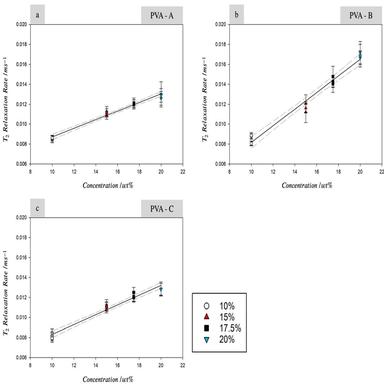
MR T2 Relaxation Rate vs. concentration for PVA-A (a), PVA-B (b), and PVA-C (c). Points show average T2 Relaxation Rate for each sample. Error bars show intra-sample standard deviation. Dashed lines show 95% confidence intervals for regression.